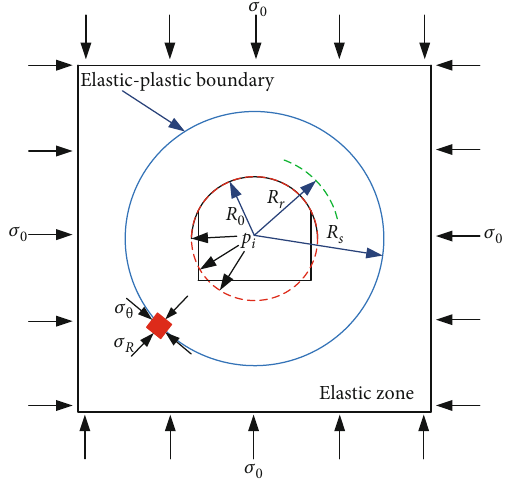
Figure 1: Plastic zone formed around equivalent circular